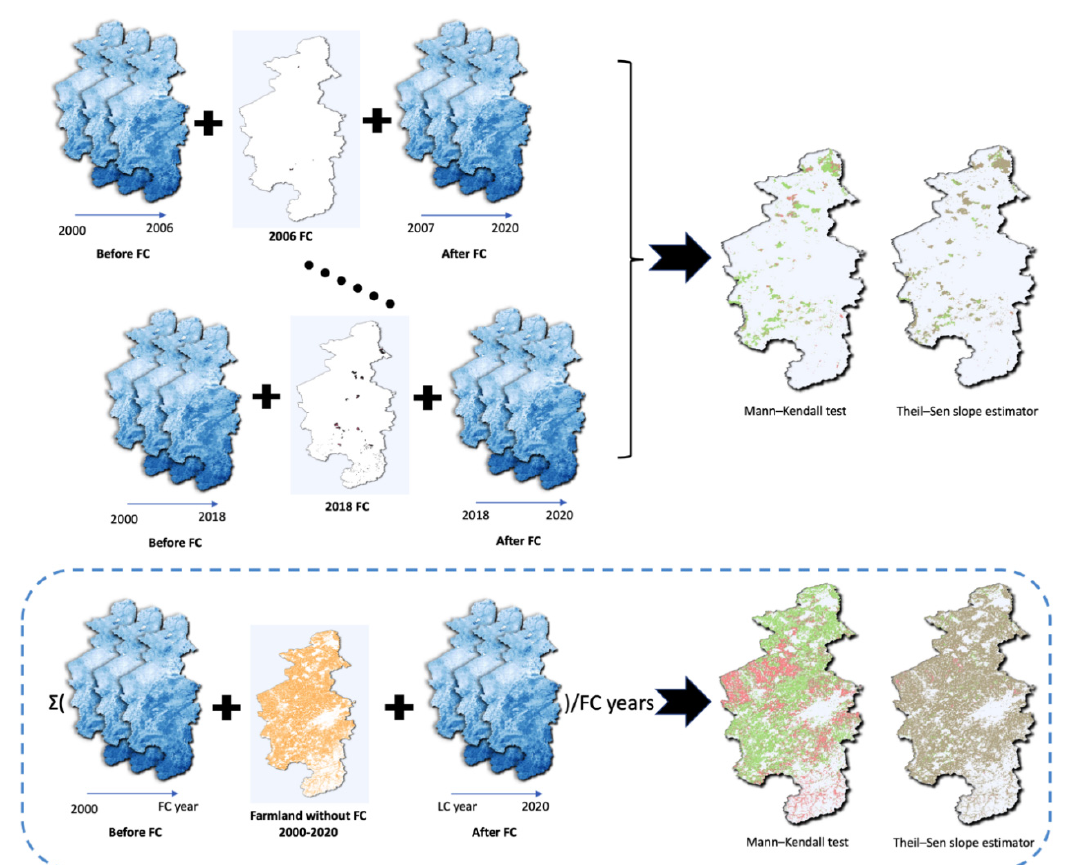
Figure 3. The trend analysis procedure. FC, farmland consolidation. Outside the dashed box is the trend analysis of the changes in the quality of the ecological environment in the FC plots, and inside the dashed box is the trend analysis of the quality changes in the ecological environment in the stable farmland without FC.